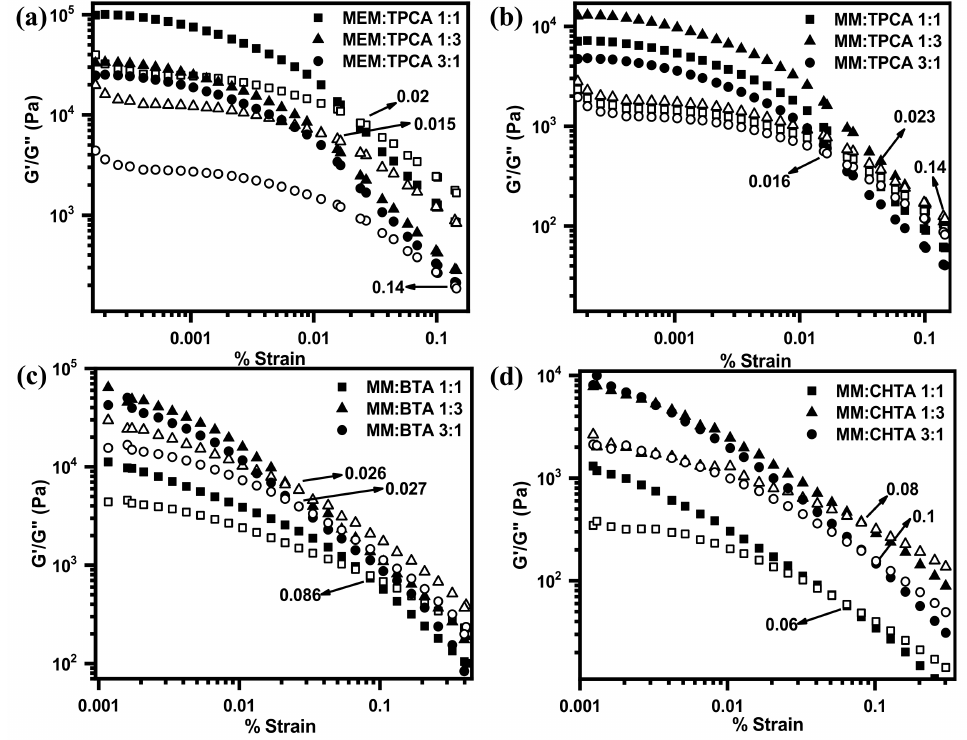
Figure 8. Strain sweep of ( a ) MEM–TPCA, ( b ) MM–TPCA, ( c ) MM–BTA and ( d ) MM–CHTA hydrogel networks at three different molar